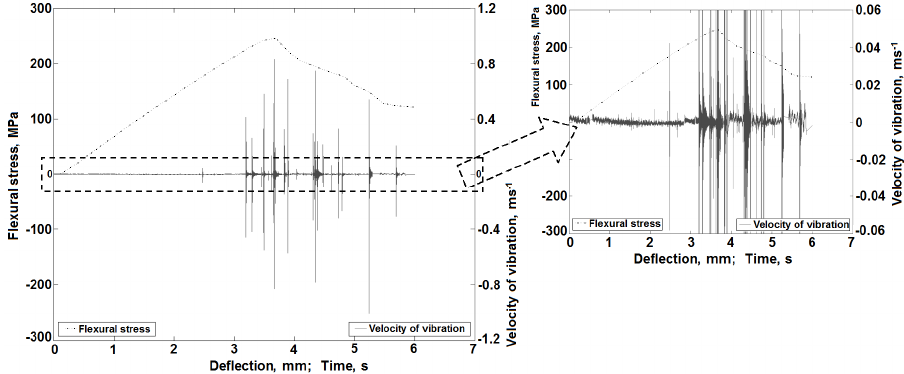
Figure 12. Characteristics of the vibration rate changes during a bending test for the classic laminate sample [53].